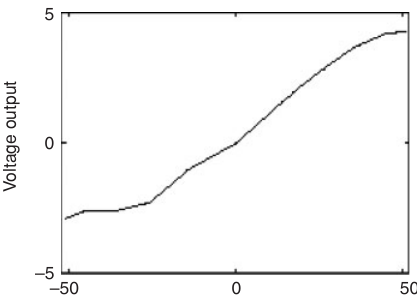
Figure 25 Experimental study with subjects 7, 8 and 9 (from top to bottom).